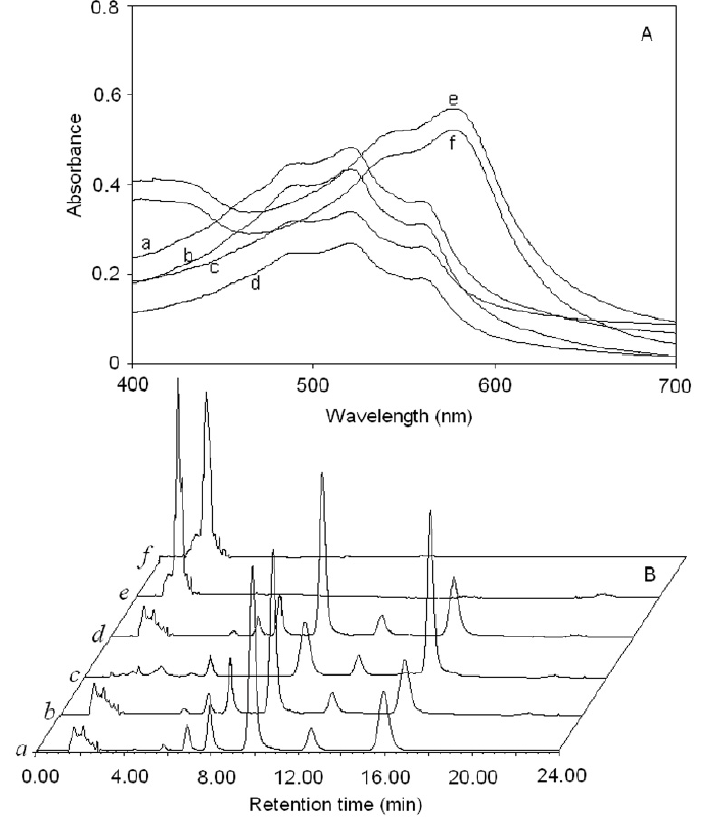
Figure 8. The visible spectra ( A ) and HPLC chromatograms ( B ) of samples extracts by different methods. (a) homogenate extraction; (b) ultrasonic extraction; (c) supercritical fluid CO extraction; (d) maceration extraction; (e) microwave extraction; (f) hot reflux 2